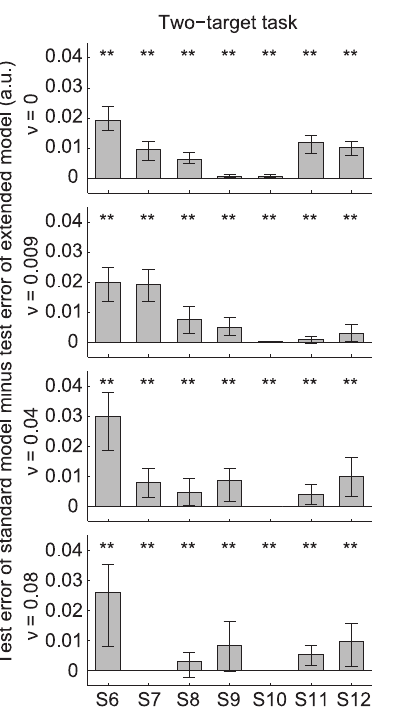
Figure 5. Model performance of the two-target task. See figure 3 for